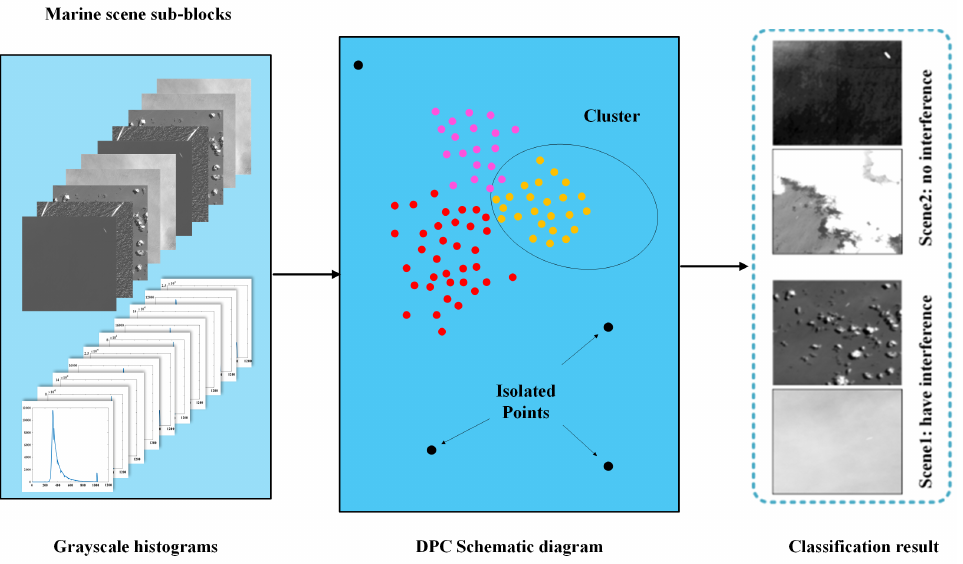
Figure 3. Marine scene classification algorithm based on density peak clustering. First, the grayscale curves of different marine scene sub-blocks are employed as the input of DPC algorithm. Then, these sub-blocks automatically gather to form 5 clusters, representing that marine scenes are classified into five